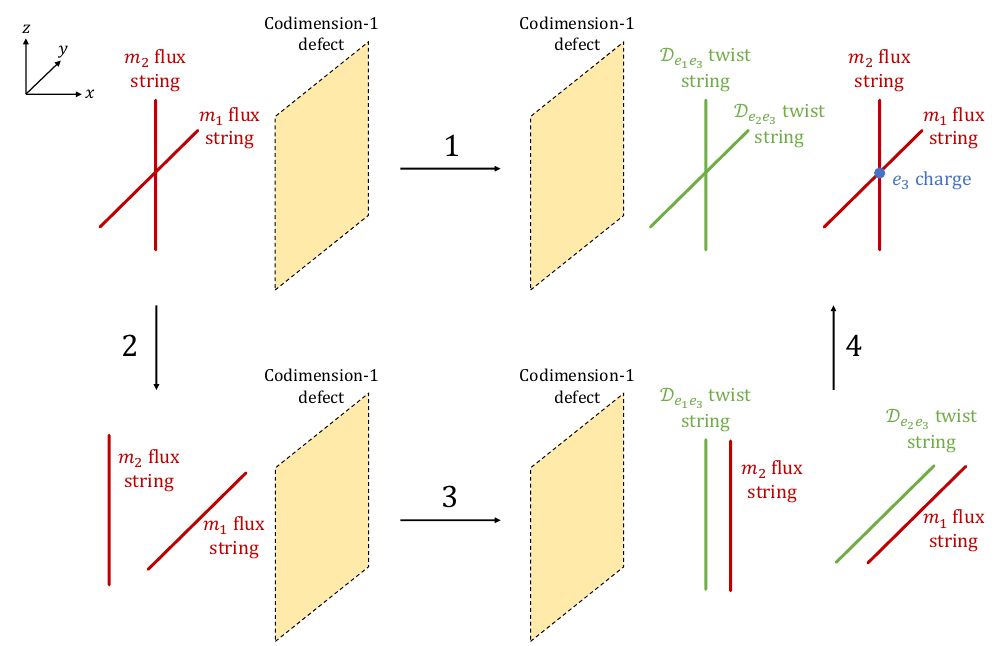
Figure 28: The process 1 corresponds to Eqs. (116) and (121). This